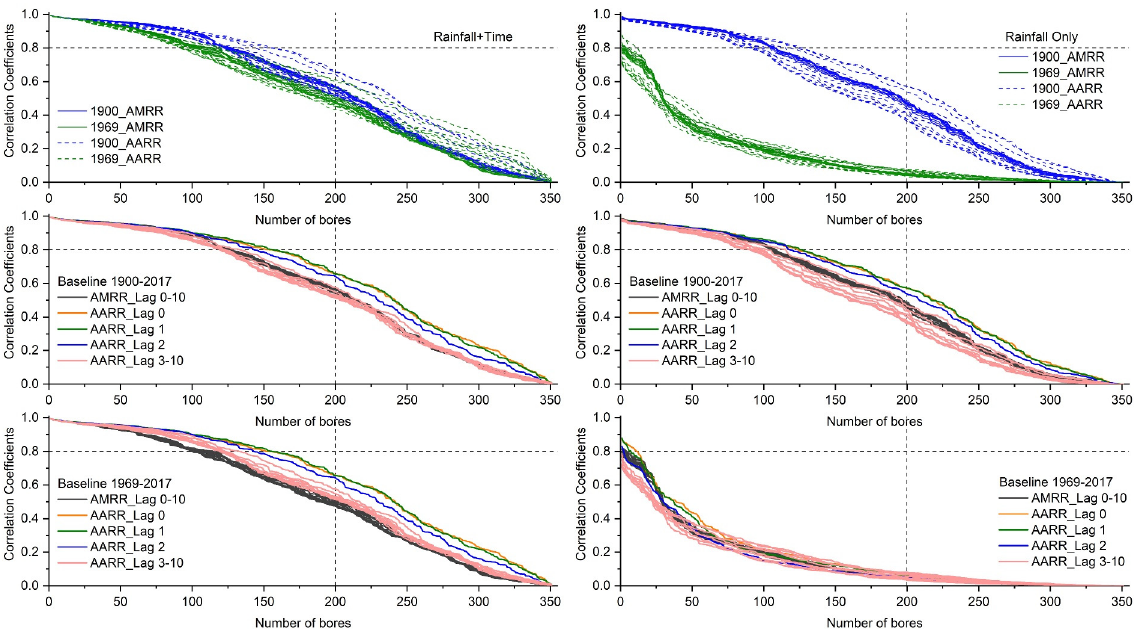
Figure 17. Results of the HARTT model.